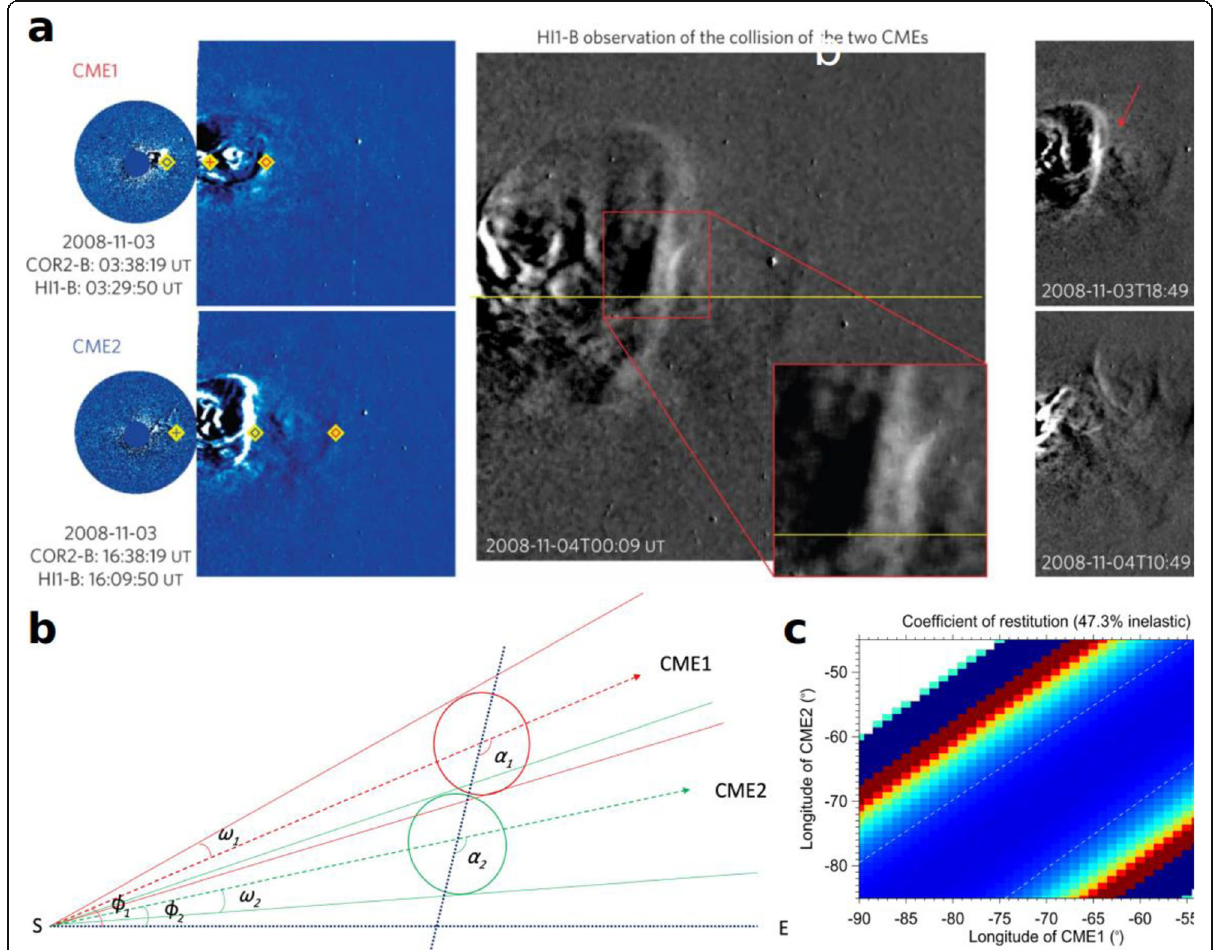
Fig. 10 a The super-elastic collision of two interacting CMEs observed in STEREO/HI (Shen et al. 2012). b Oblique collision of two CMEs assumed as spherical bubbles (Mishra et al.,). c The variation of the restitution coefficient with the uncertainties of pre-collision longitudes of CMEs considered (Mishra et